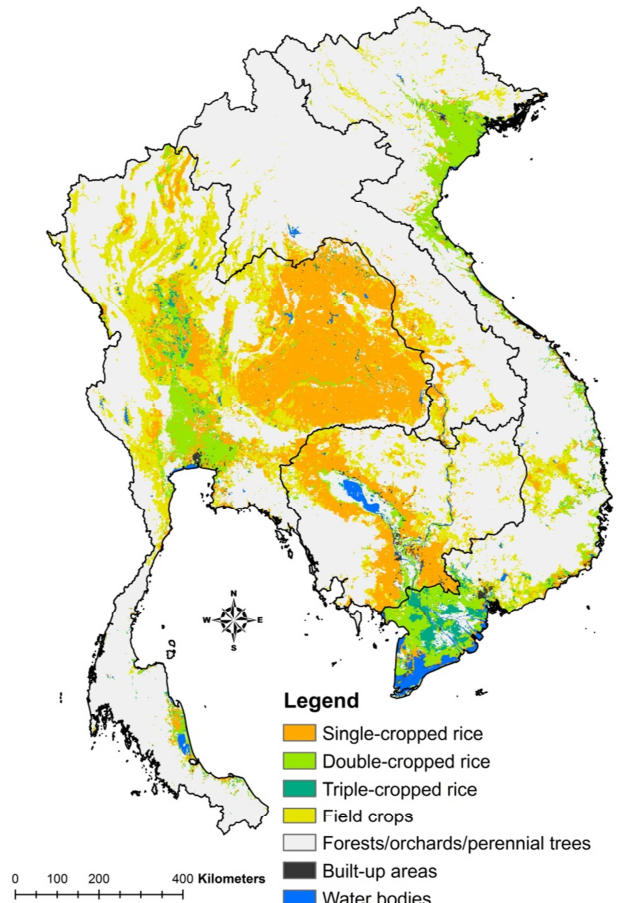
Figure 3. Spatial distribution of cropping patterns.